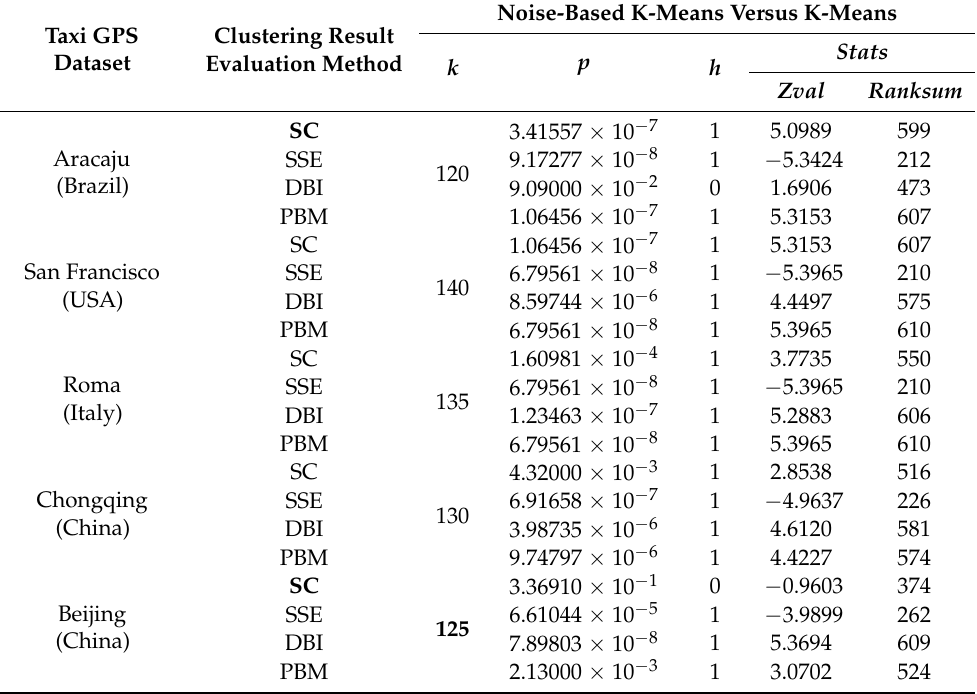
Table 9. Statistical analysis results of Wilcoxon testing for noise-based K-means vs.